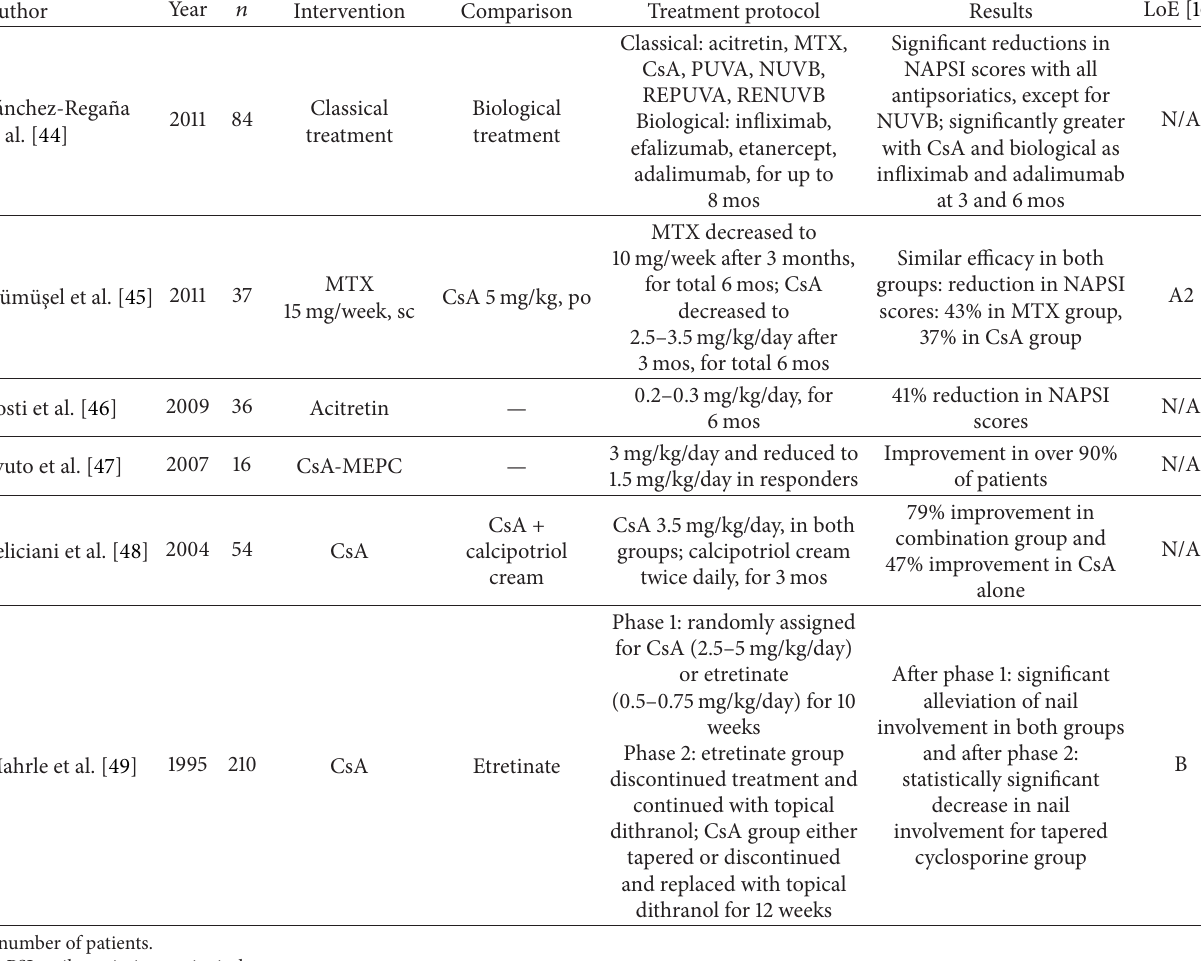
Table 2: Systemic therapies for treatment of nail